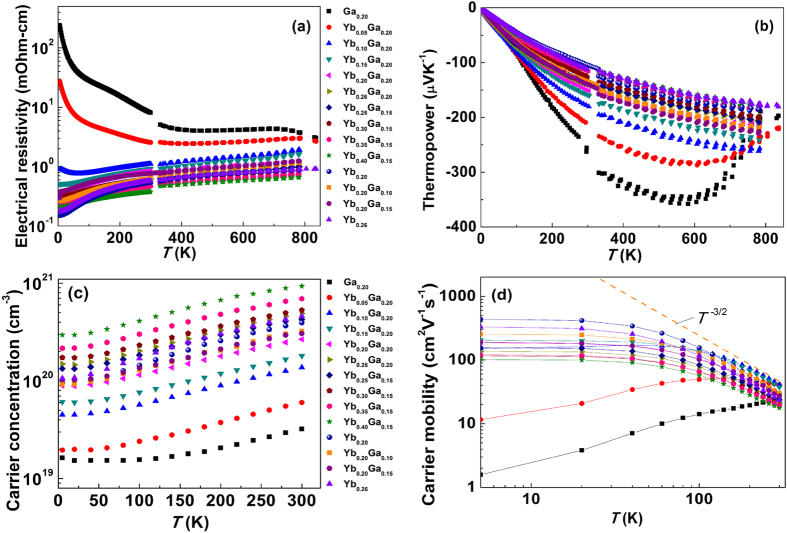
Electrical properties as a function of temperature.(a) Electrical resistivity, (b) thermopower, (c) carrier concentration and (d) carrier mobility of YbxGa0.2Co4Sb11.9333 (x = 0, 0.05, 0.10, 0.15, 0.20, 0.26), YbyGa0.15Co4Sb11.95 (y = 0.25, 0.30, 0.35, 0.40), Yb0.20GazCo4Sb12-z/3 (z = 0, 0.10, 0.15) and Yb0.26Co4Sb12. The dashed line in (d) represents the temperature dependence of T−3/2, indicating an acoustic phonon scattering trend line for eye guidance.